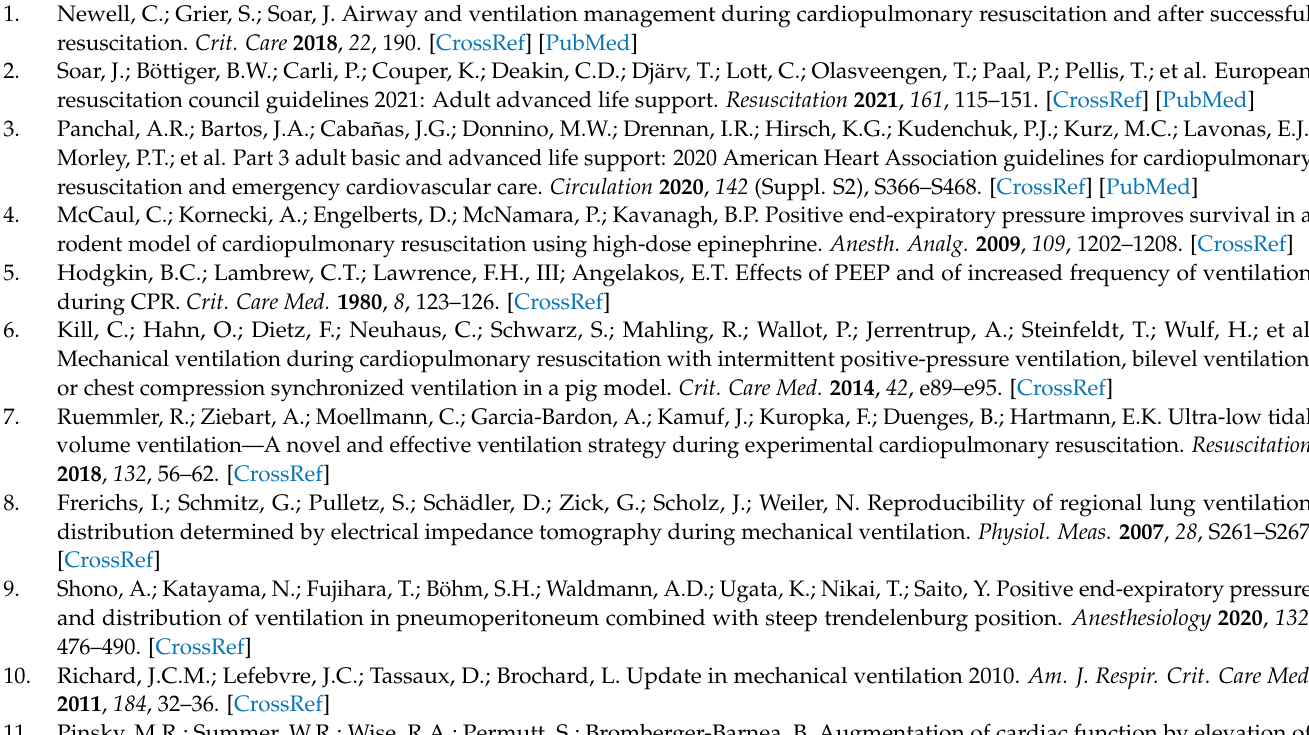
pictured. There were no significant differences detected. Figure S2: Microphotographs of